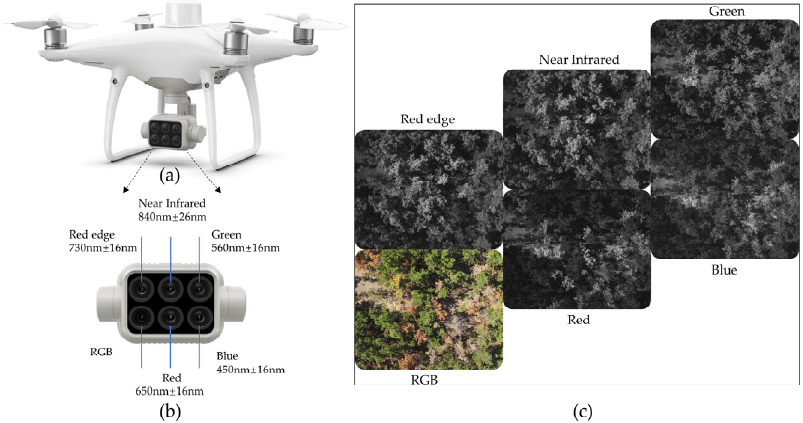
Figure 2. ( a ) DJI Phantom 4 Multispectral Edition; ( b ) multispectral camera with six lenses; ( c ) an RGB sample along with the reflectance in the different multispectral bands.